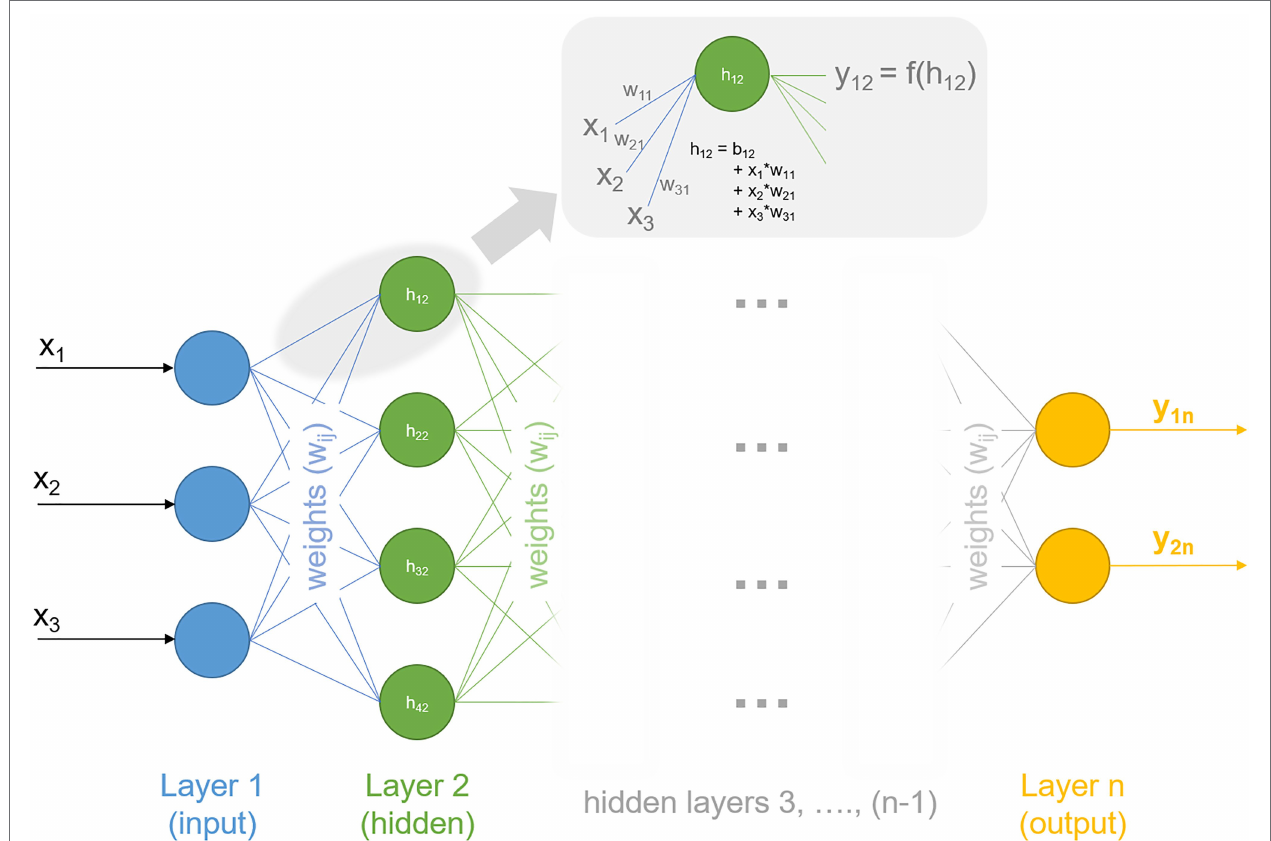
FIGURE 2 | An artificial neural network. Information, i.e., x 1 , x 2 , and x 3 , enters the network via the input layer (layer 1, blue). Weights w ij determine the quantity by which information is passed to layer 2 (hidden, green). Processed information, here y 1n and y 2n , leaves the network by the output layer (layer n, yellow). Indices refer to neuron number and layer number, respectively. Calculations for neurons are depicted exemplarily for h 12 (first neuron in second layer), which is composed of a bias (b 12 ) and summed information of the previous layer, here layer 1. Resulting information, y 12 , is passed to the next layer and might comprise nonlinearities in f(h 12 ). Deep neural networks typically comprise several and up to numerous hidden layers, indicated in